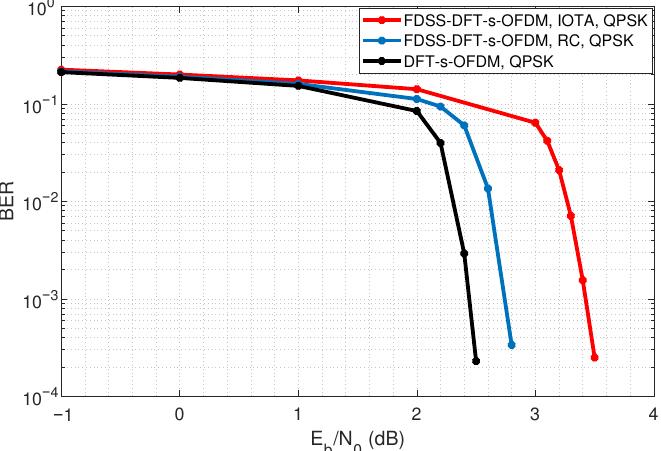
Figure 17. Effect of FDSS on BER